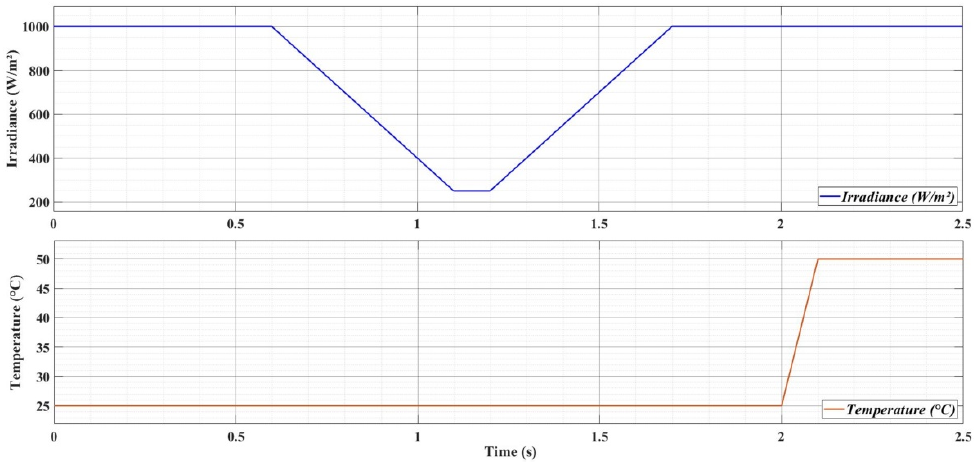
Figure 27. The time evolution of irradiance and temperature (signal evolution of the type 1 PV array).